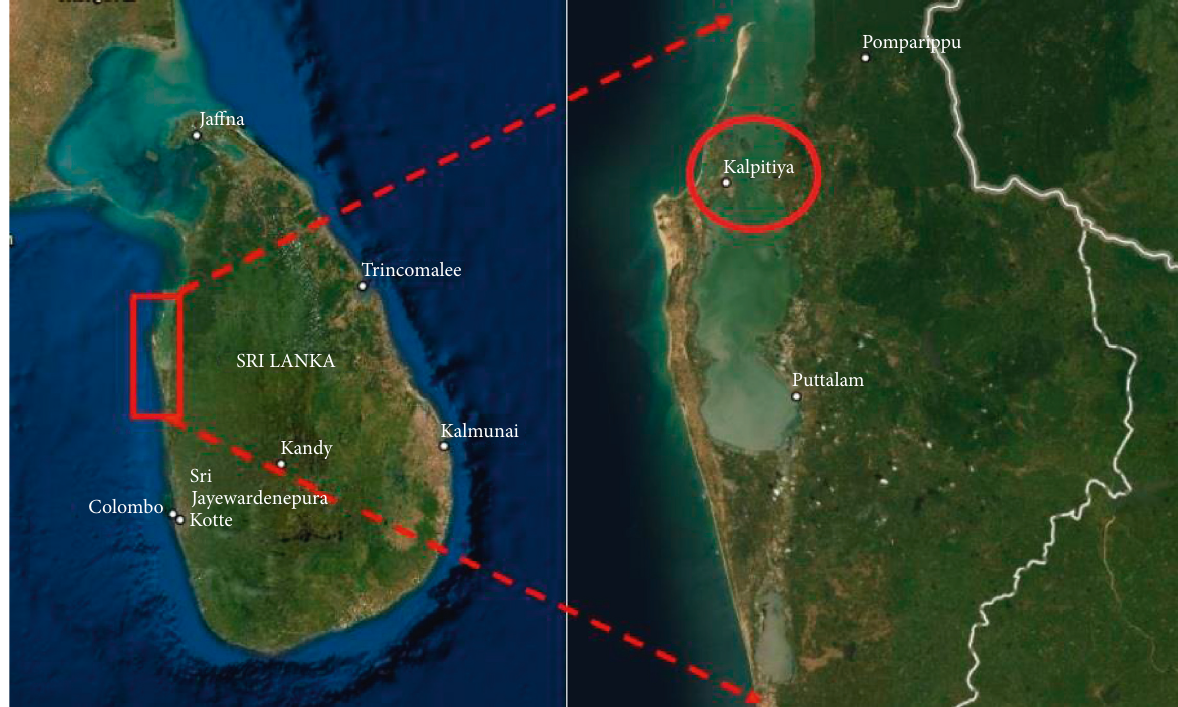
Figure 2: Location of Pawan Danavi wind